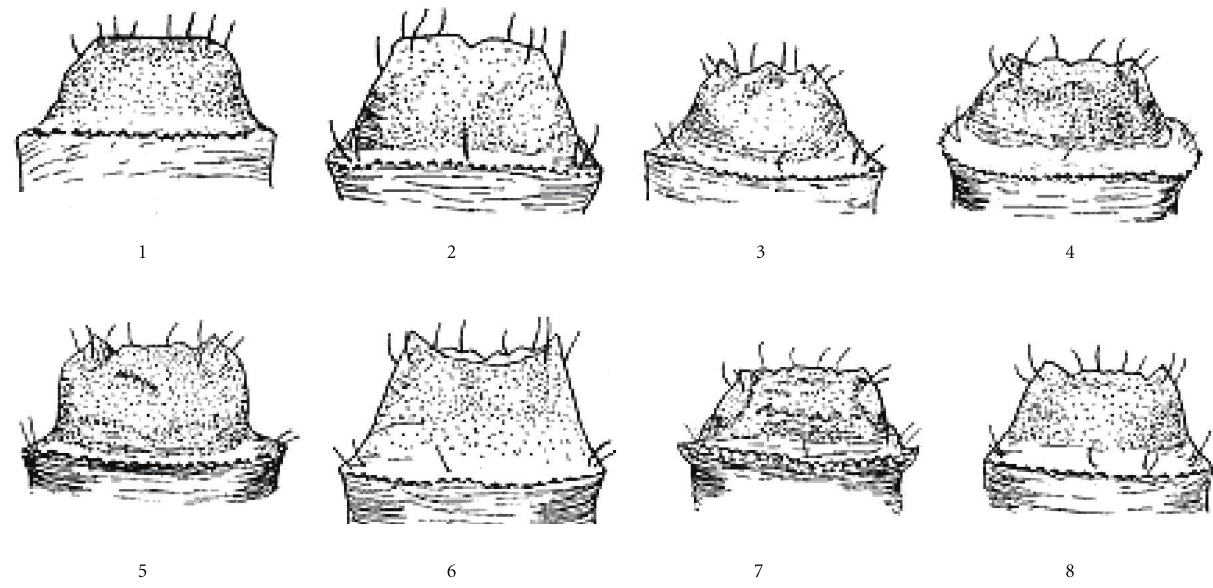
Figure 1: Variants of the T. viridana L. pupae cremasters with 1–8 peaks at their tops